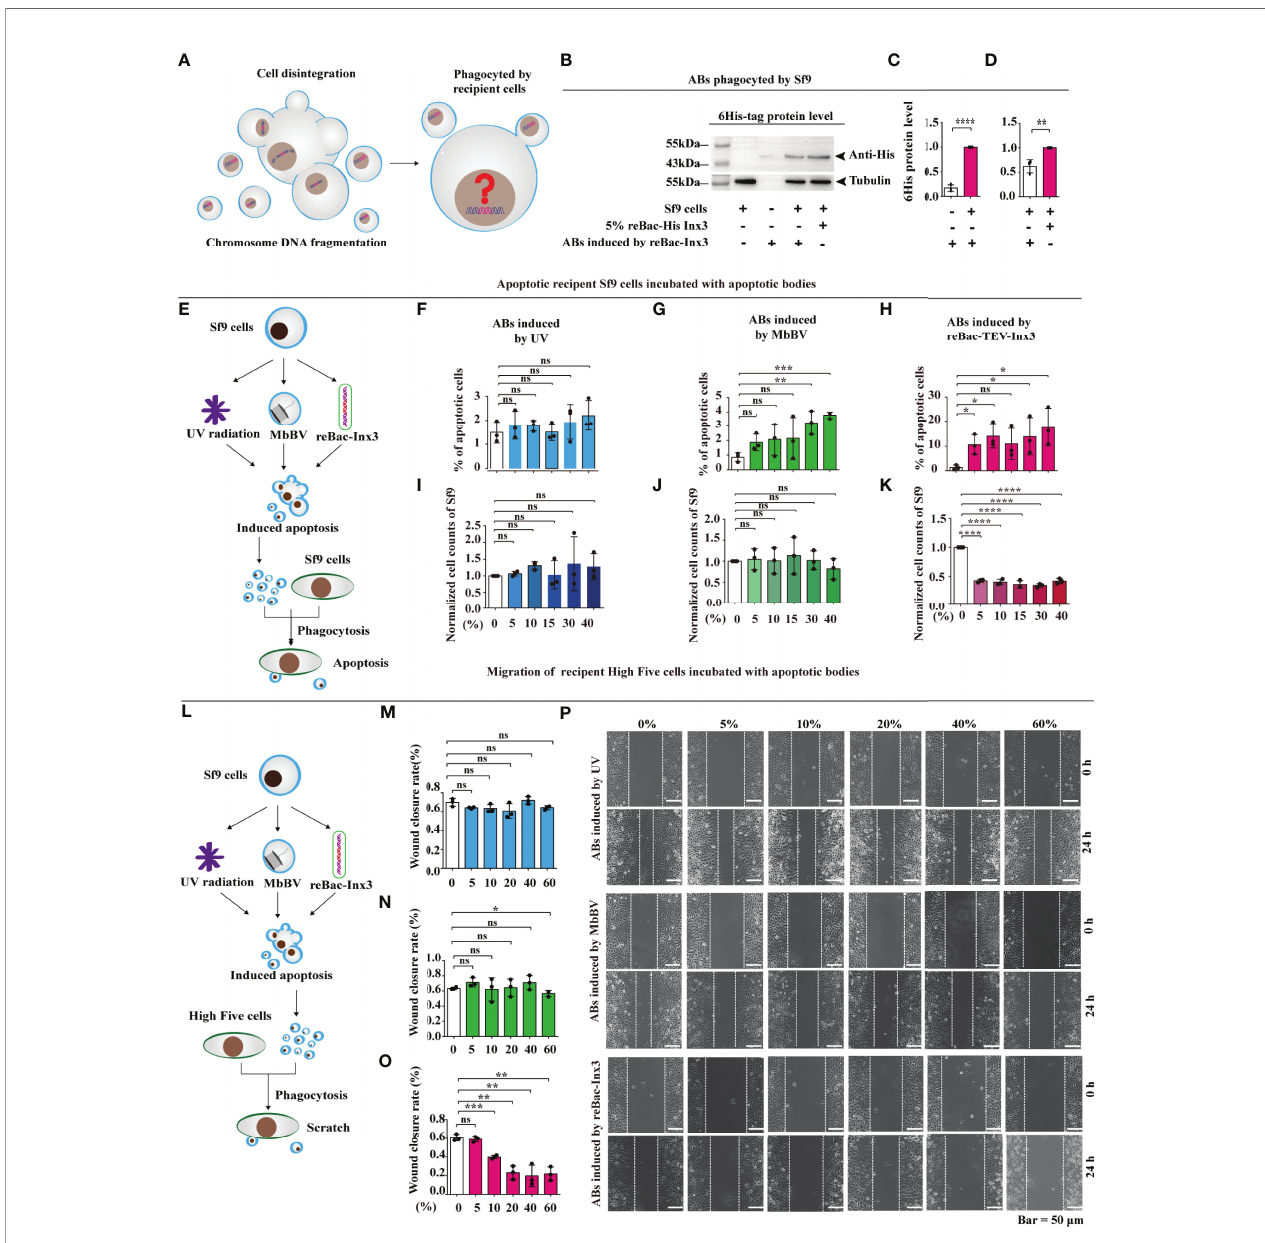
FIGURE 1 | Bracovirus-induced ABs transmit immunosuppressive signaling. (A) Schematic illustration of the fate of the extracellular vesicles phagocytosed by the recipient cells. (B – D) Western blot detection of 6 × His labeled AB of the recipient cells. ** p < 0.01, **** p < 0.0001, error bars represent SEM. Unpaired Student ’ s t - test with Holm-Sidak method for multiple t test; n = 3. (E – K) Formation of ABs induced by MbBV mediated apoptosis of recipient Sf9 cells. Flowchart showing the formation of ABs generated by UV, MbBV, reBAc-His-Inx3 (E) . The detection of apoptotic recipient Sf9 cells incubated with UV-induced AB (F) , MbBV-induced AB (G) and re-Bac-Inx3-induced AB compared with different concentration (H) . The detection of cell numbers of recipient Sf9 cells after incubation with UV-induced AB (I) , MbBV-induced AB (J) and re-Bac-Inx3-induced AB compared with different concentration (K) . * p < 0.05; ** p < 0.01; *** p < 0.001; **** p < 0.0001; ns, no signi fi cant difference; error bars represent SEM. Unpaired Student ’ s t -test with Holm-Sidak method for multiple t test; n = 3. (L – P) Formation of ABs mediated by MbBV inhibited the migration of recipient High Five cells. The fl owchart offormation of ABs generated by UV, MbBV reBAc-His-Inx3 (L) . The detection of migration recipient High Five cells incubated with UV-induced AB (M) , MbBV-induced AB (N) , and reBac-Inx3-induced AB (O) . Scratch assays in recipient High Five cells (P) . Scale bar, 50 m m. * p < 0.05, ** p < 0.01, *** p < 0.001, ns, no signi fi cant difference, error bars represent SEM. Unpaired Student ’ s t -test with Holm-Sidak method for multiple t test; n = 3. See also Figure S1